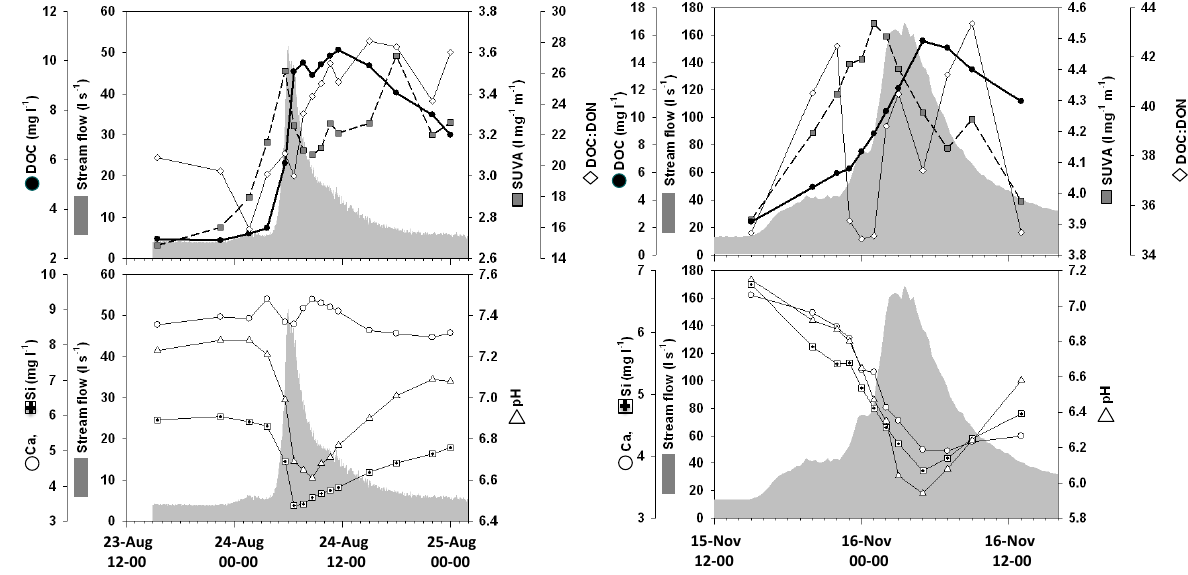
Fig. 3. Temporal change in flow and solute properties during storms in August-2005 (a) and November-2006 (b) .